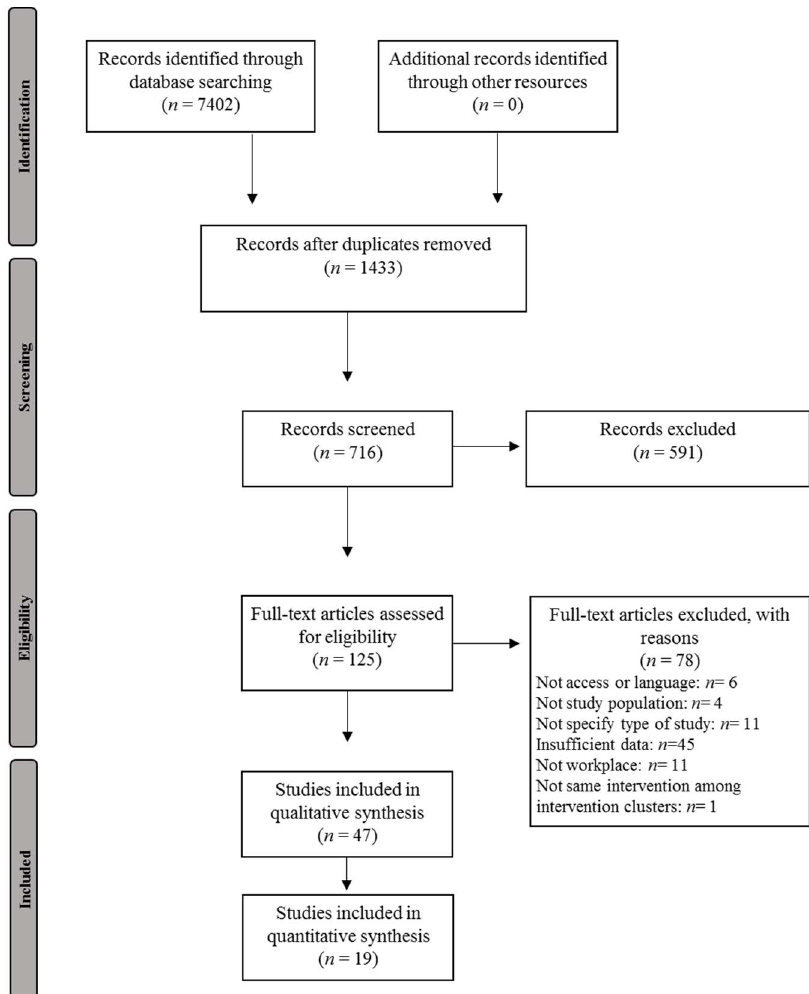
Figure 1. Flow diagram of included studies in the systematic review and meta-analysis.